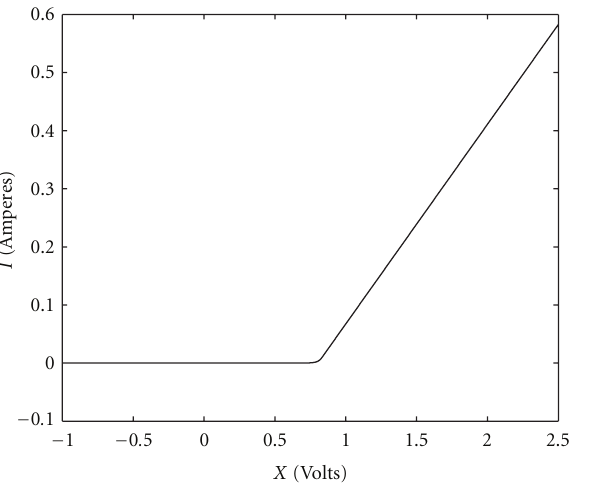
Figure 2: Parameterised I - X relationship for a diode.